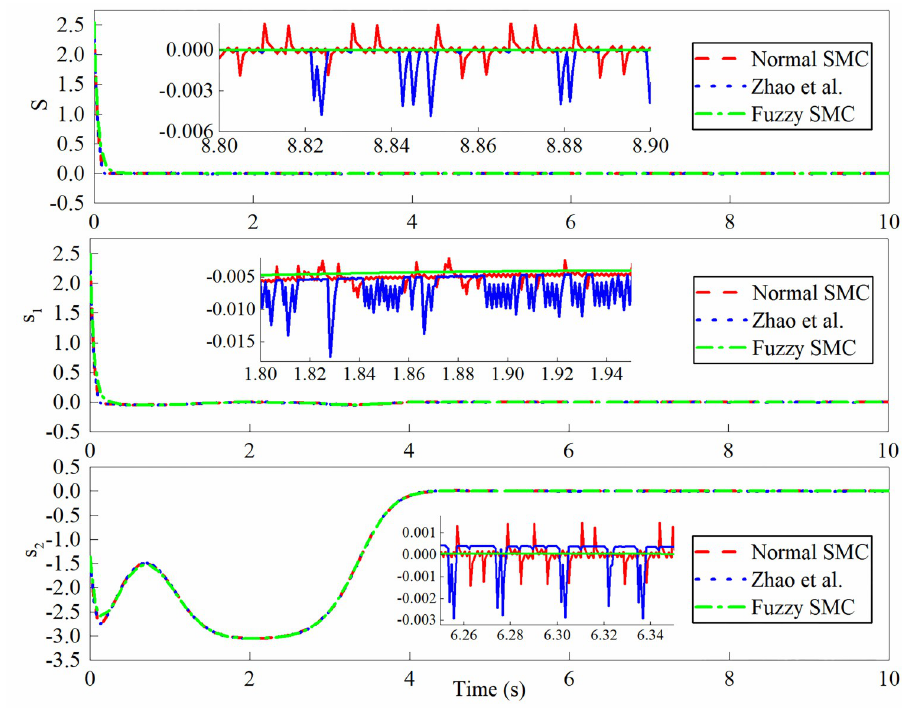
Fig 15. Sliding mode